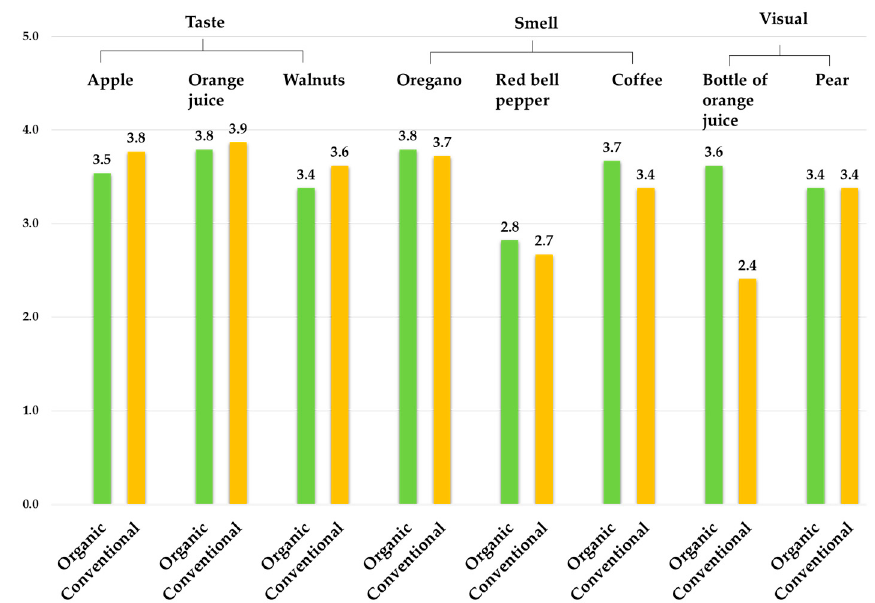
Figure 4. Overall liking mean values for each of the sample (organic and conventional products) on a 5-point scale: 1 = I strongly dislike, 5 = I strongly like.